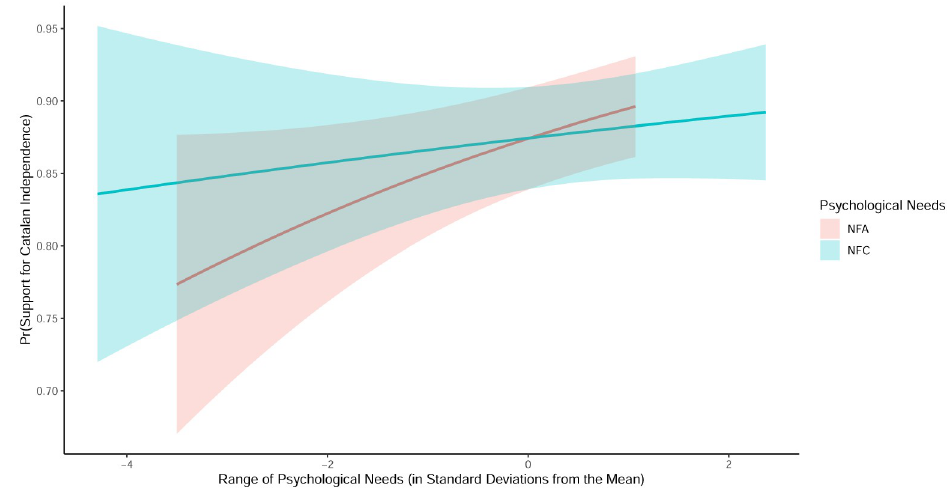
Fig 2. Main effects of NFA and NFC on support for Catalan independence (Main-effect model). Note : Predictions are based on Model 3 from Table 1.